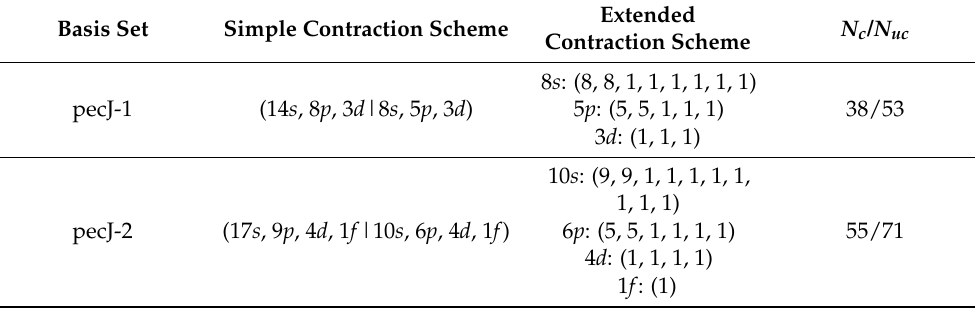
Table 2. Contraction schemes of the pecJ- n basis sets for P and Si. Basis Set Simple Contraction Scheme